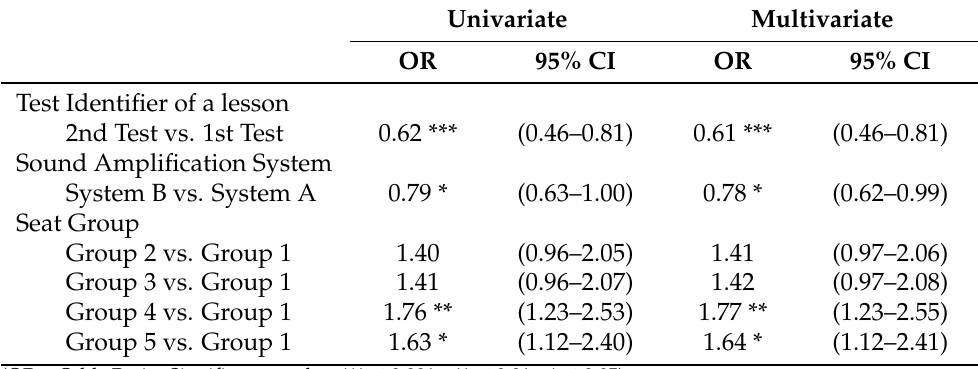
Table 9. Logistic Regression: sub analysis 2 (Level 4 (the hardest) data only).